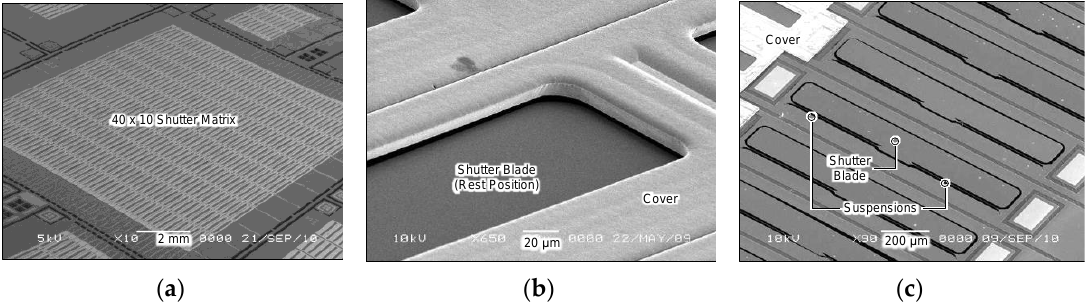
Figure 2. Scanning electron microscope (SEM) images of micro shutter array. ( a ) Entire view of a 40 × 10 array, ( b ) close-up view of the shutter blade and the cover plate, and ( c ) the shutter blade after removal of the cover plate.